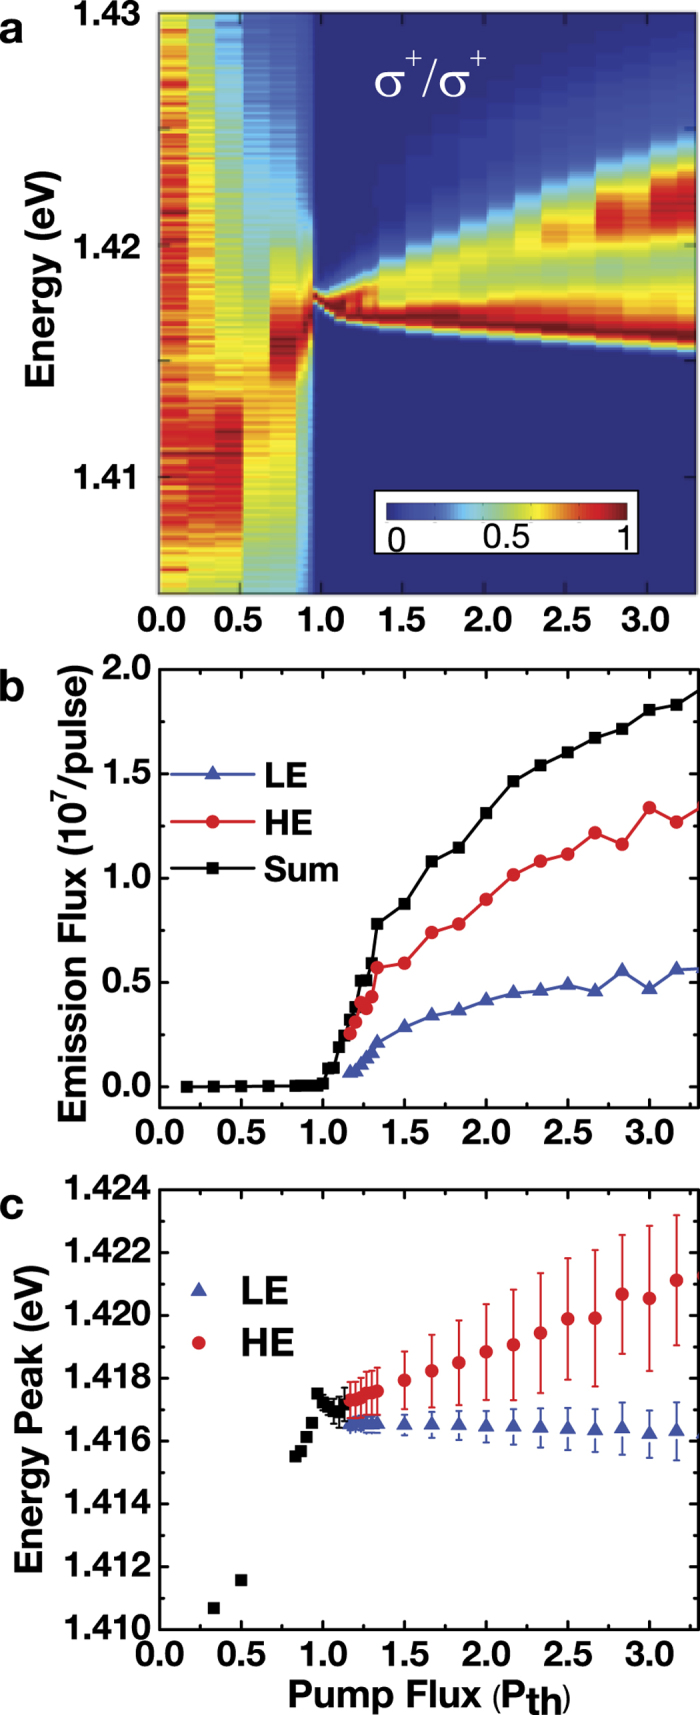
Spectral characteristics of dual-energy (two-state) lasing.(a) Normalized time-integrated spectra of the co-circular (σ+/σ+) emission component for  μm−1. (b) Emission flux of the HE state (solid red circles), the LE state (solid blue triangles), and the sum (solid black squares). (c) Peak energies (solid shapes) and linewidths (error bars) of the HE state (solid red circles) and LE state (solid blue triangles). The peak energies below the threshold are represented by the solid black squares. The emission fluxes, peak energies, and linewidths are determined by fitting of the spectra with multiple-Gaussian functions. The photoexcited density at the threshold pump flux (Pth) is  cm−2 per quantum well per pulse.